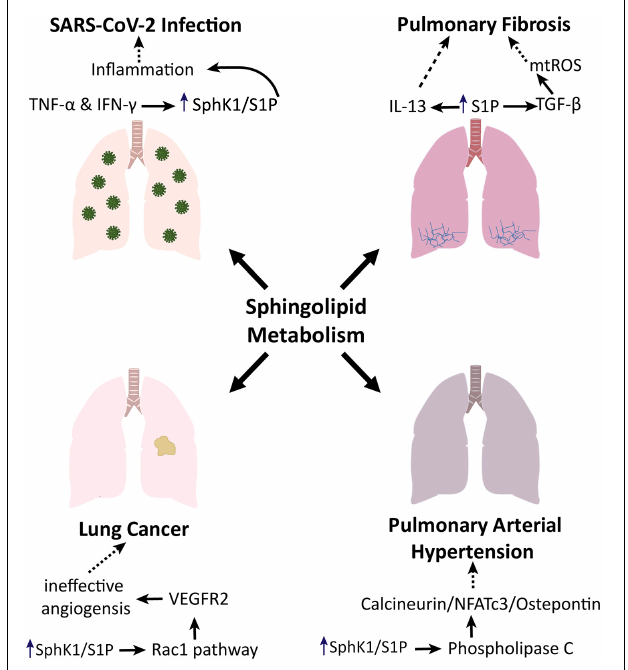
FIGURE 2 | Sphingolipid metabolism in lung pathologies. Sphingolipid metabolism promotes pulmonary fibrosis via TGF- and IL-13 signaling. Sphingolipid metabolism induces phospholipase C to enhance the progression of pulmonary arterial hypertension. In the context of lung cancer, sphingolipid metabolism has been shown to impact angiogenesis via the Rac1 pathway. Additionally, sphingolipid metabolism is involved in the inflammatory phenotype associated with SARS-CoV-2